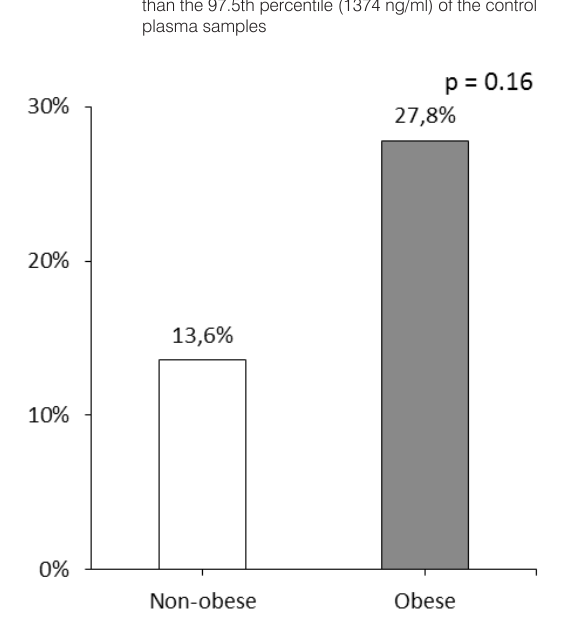
Figure 1 . Percentage of individuals with elevated BAFF higher than the 97.5th percentile (1374 ng/ml) of the control plasma